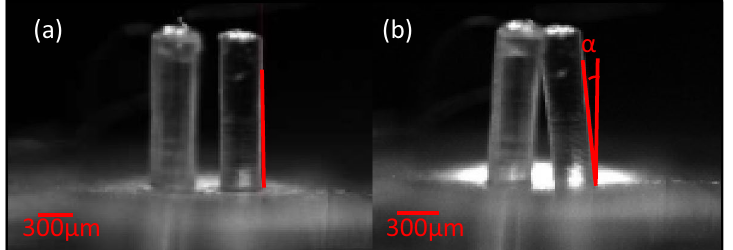
Figure 5. The side view of fingers, and the side view of bending fingers and bending’s angle. ( a ) The side view of the microgripper’s fingers. ( b ) The side view of the bending finger and the measured angle of bending (α).